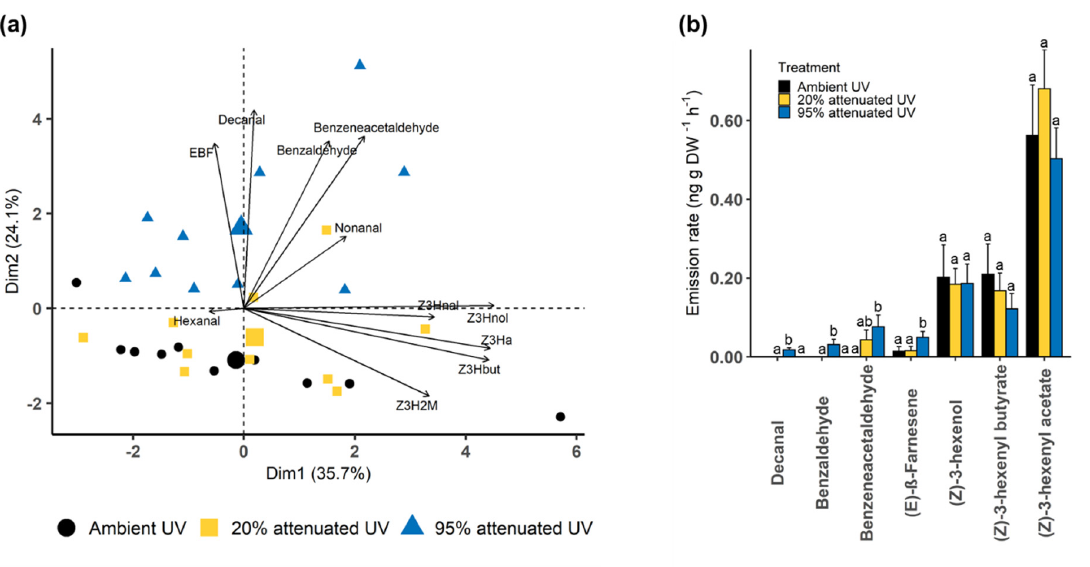
Figure 2. ( a ) Principal component analysis (PCA) biplot based on the volatile compounds produced by heather under ambient, 20% attenuated and 95% attenuated UV. ( b ) The relative proportion of compounds with higher contributions to PC1 and PC2 between the three UV treatments (n = 10). Y -axis of barplot ( b ) shows log10x + 1 transformed mean ± SE emission rate compounds and different letters indicate significant differences. Abbreviations in PCA: ( E )- β -farnesene (EBF), ( Z )-3-hexenal (Z3Hnal), ( Z )-3-hexenol (Z3Hnol), ( Z )-3-hexenyl acetate (Z3Ha), ( Z )-3-Hexenyl butyrate (Z3Hbut), ( Z )-3-hexenyl 2-methylbutyrate (Z3H2M).